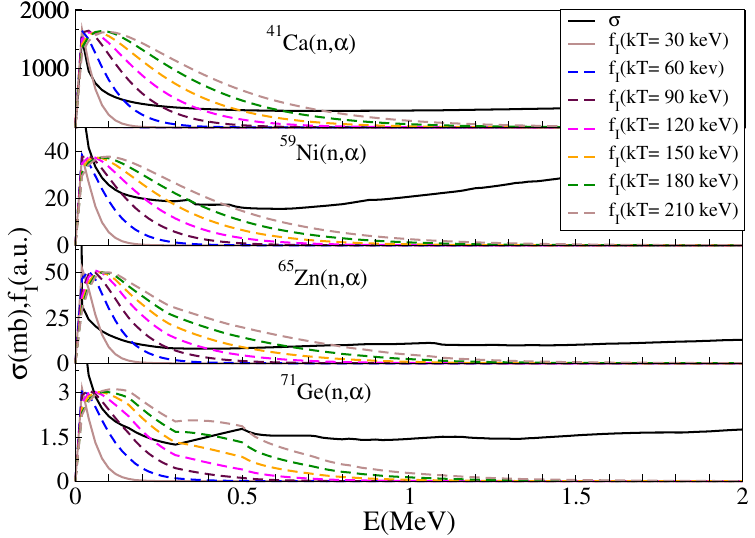
Figure 9. The same as Figure 7, but for 41 Ca, 59 Ni, 65 Zn, and 71 Ge target